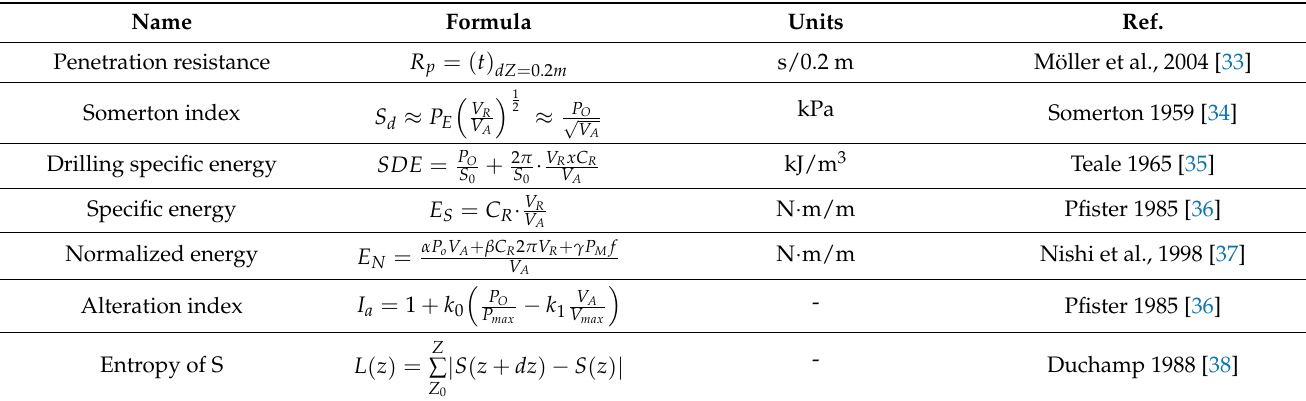
Table 1. Most used compound